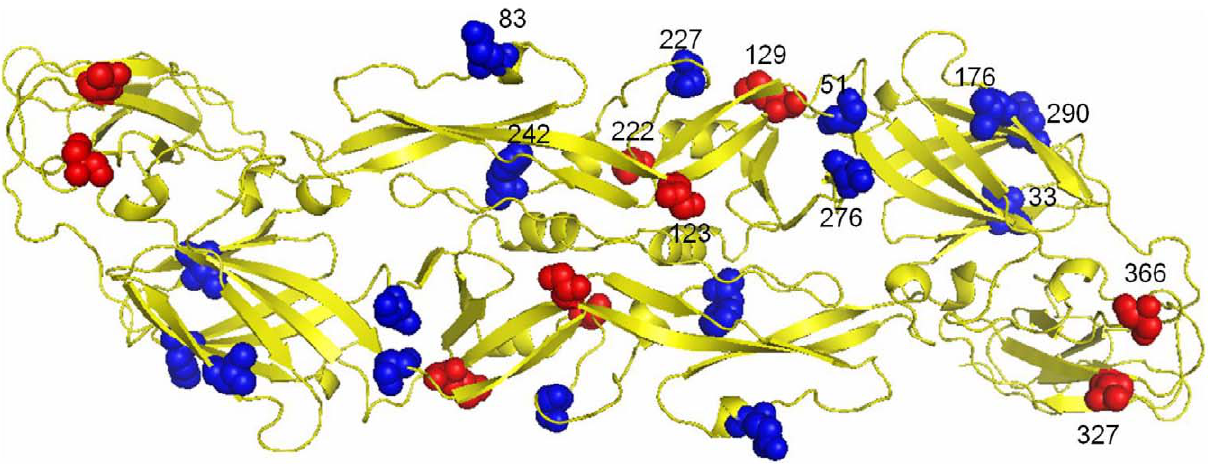
Figure 1. Structural locations of Japanese encephalitis virus (JEV) envelope (E) protein variations. Amino acid variations between the Nakayama vaccine strain and the GIII brain-isolated CJN strain are indicated in blue, and variations between the Nakayama vaccine strain and the GI field-isolated TC2009-1 strain are indicated in both blue and red.